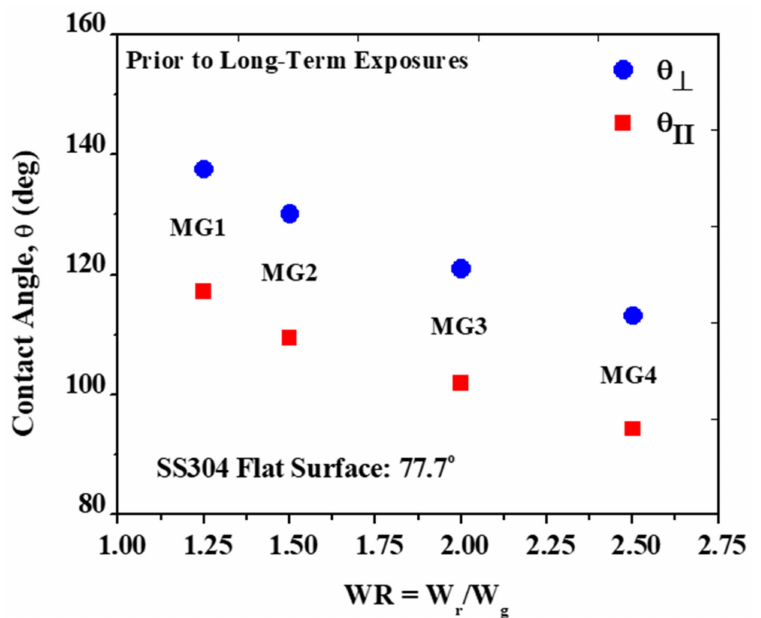
Figure 4. Contact angles of MG ( θ ⊥ , θ Π ), prior to their long-term exposures to 3.5 wt. % NaCl solution, as a function of their width ratio (WR = W r /W g ). Table 2. Contact angle of surfaces prior to long-term exposures to 3.5 wt. % NaCl solution. θ r values ( θ r = CA before long-term exposure − CA after long-term exposure) of surfaces: ( I ) after intermittent exposure and ( II ) after continuous exposure.